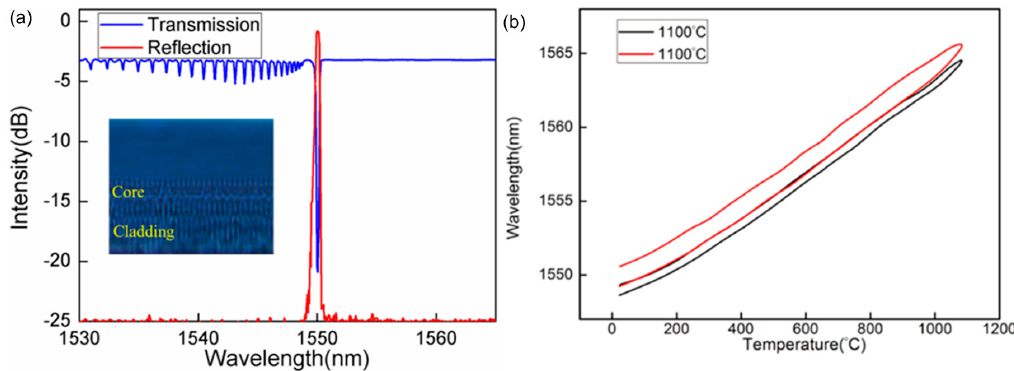
Figure 8. ( a ) Reflection and transmission spectrum of FBG written in a SMF (inset is imaging photo of FBG); ( b ) FBG wavelength versus temperature up to 1100 °C.